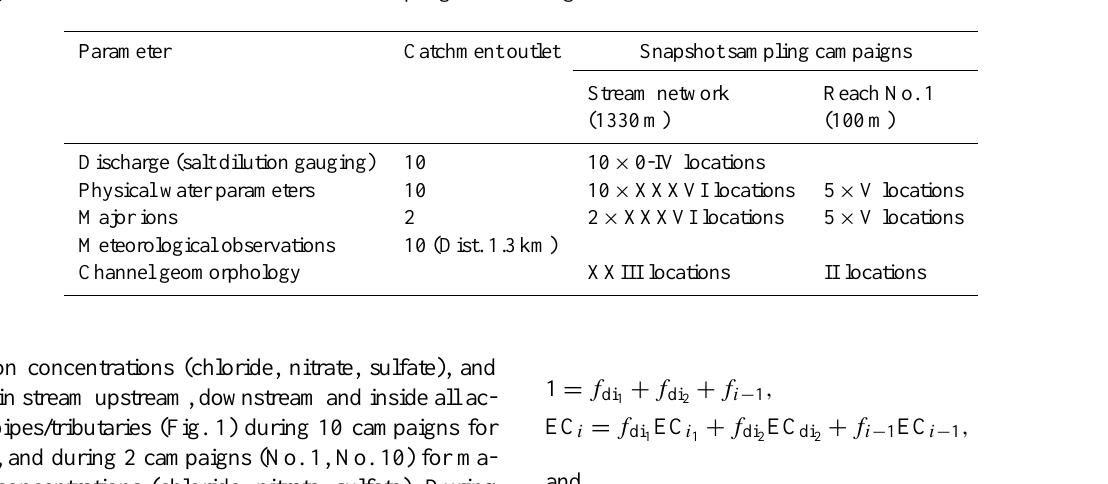
Table 1. Overview on the measurements and samples obtained during June and August 2012. The number of samples taken at a specific location is given in Arabic numerals. The number of sampling locations is given in Roman